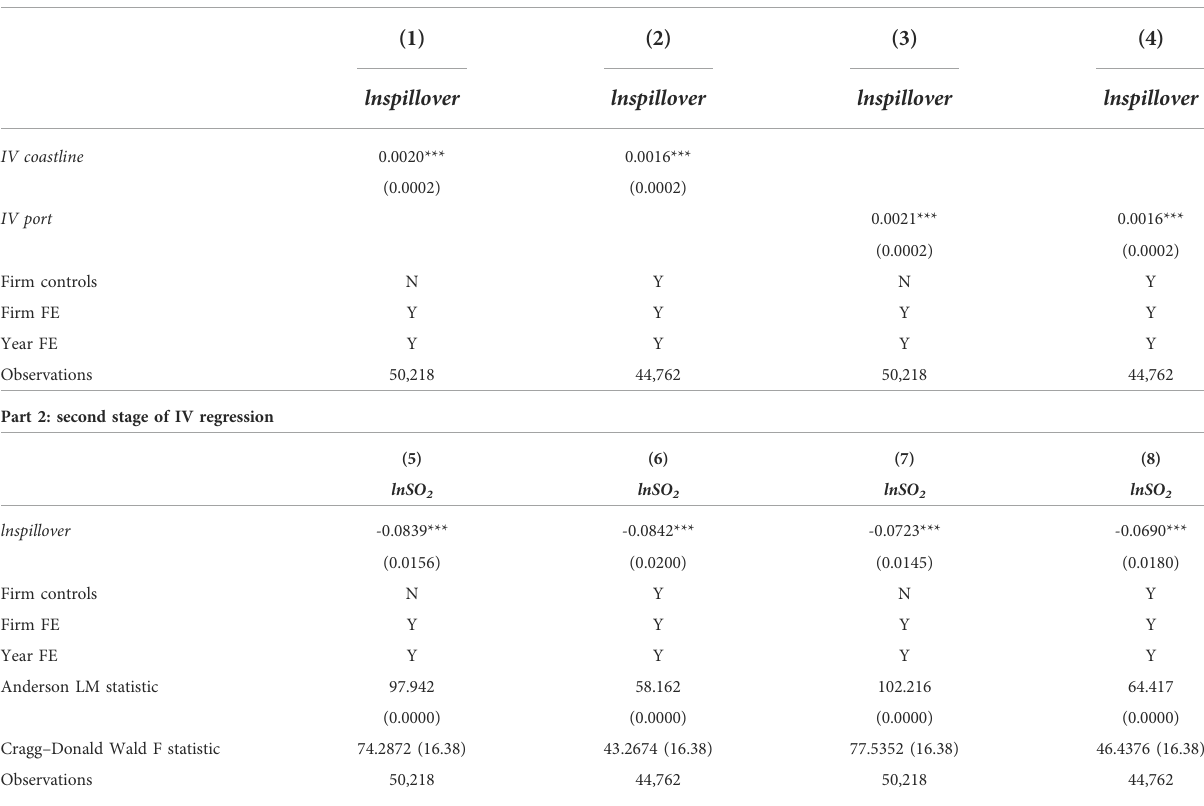
TABLE 3 Addressing the endogeneity